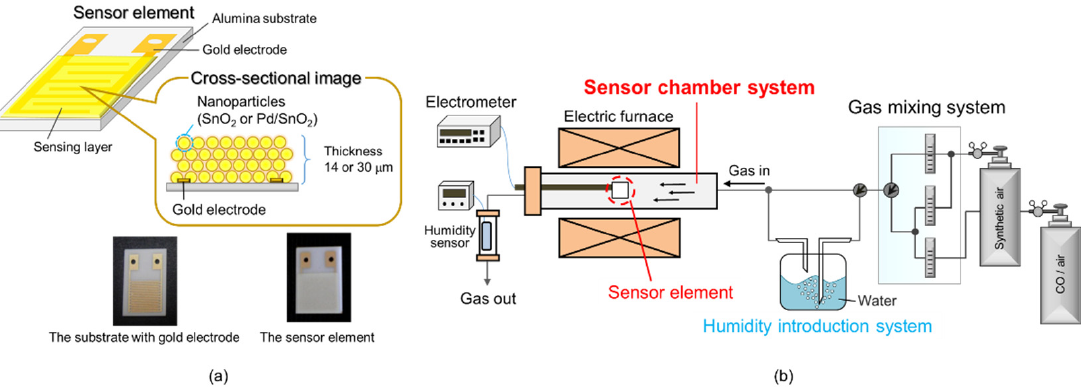
Figure 2. ( a ) Schematic image and photographs of the sensor element and ( b ) schematic image of measurement apparatus.